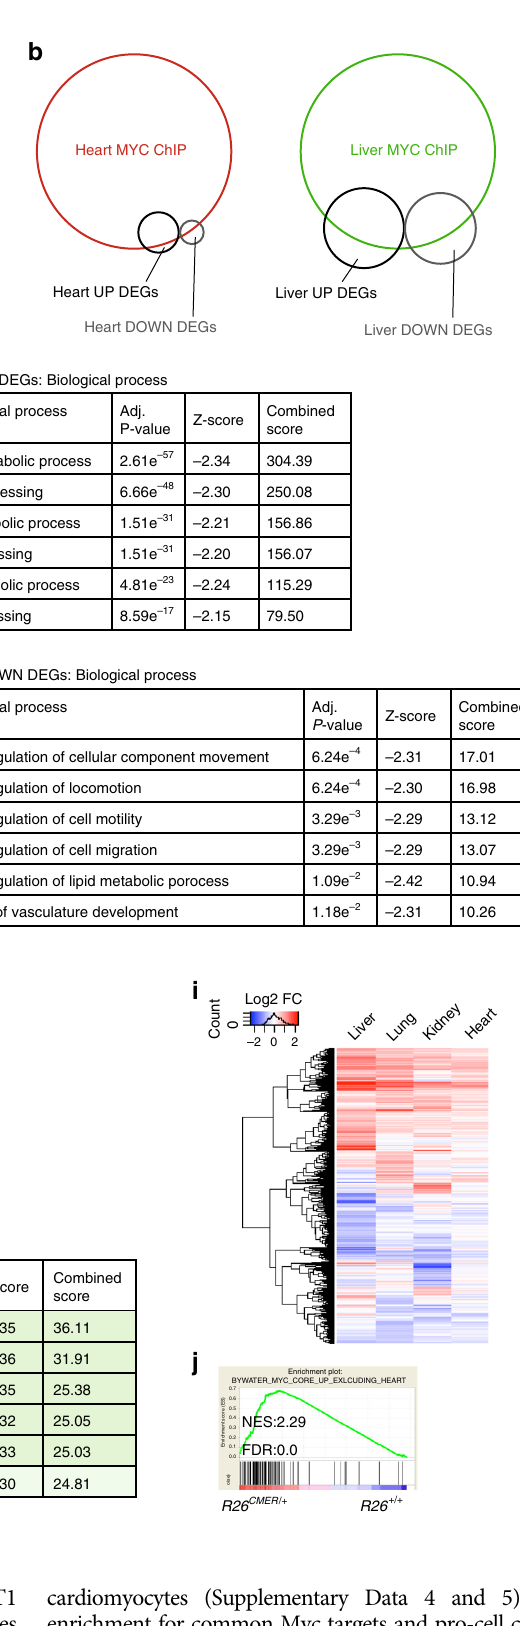
cardiomyocytes (Supplementary Data 4 and 5), with positive enrichment for common Myc targets and pro-cell cycle progression gene sets (Supplementary Fig. 8b). Positive enrichment of common Myc targets was also observed in cardiomyocytes puri fi ed from Ccnt1 -infected Myh6Cre ; R26 LSL-CMER/ + hearts vs uninfected Myh6Cre ; R26 LSL-CMER/ + hearts 4 h post activation of Myc (Fig. 8d).